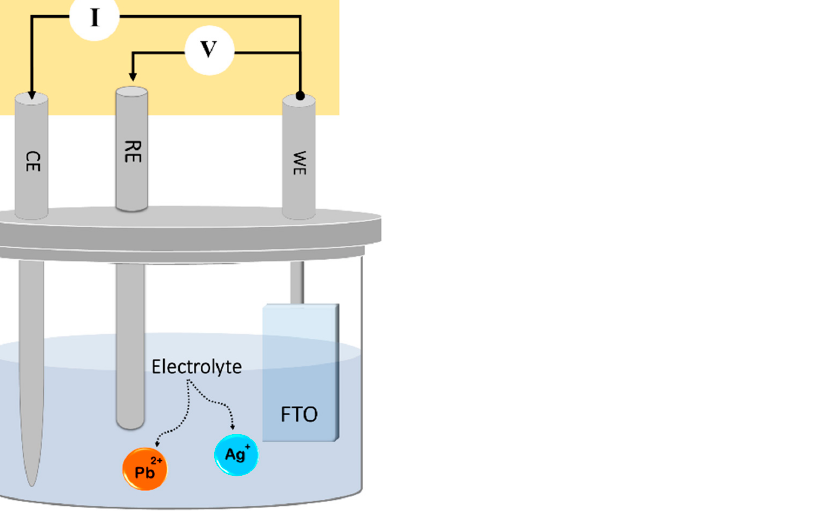
Figure 1. Electrodeposition scheme of the electrodeposition workstation: WE; working electrode, RE; reference electrode, CE; counter electrode.